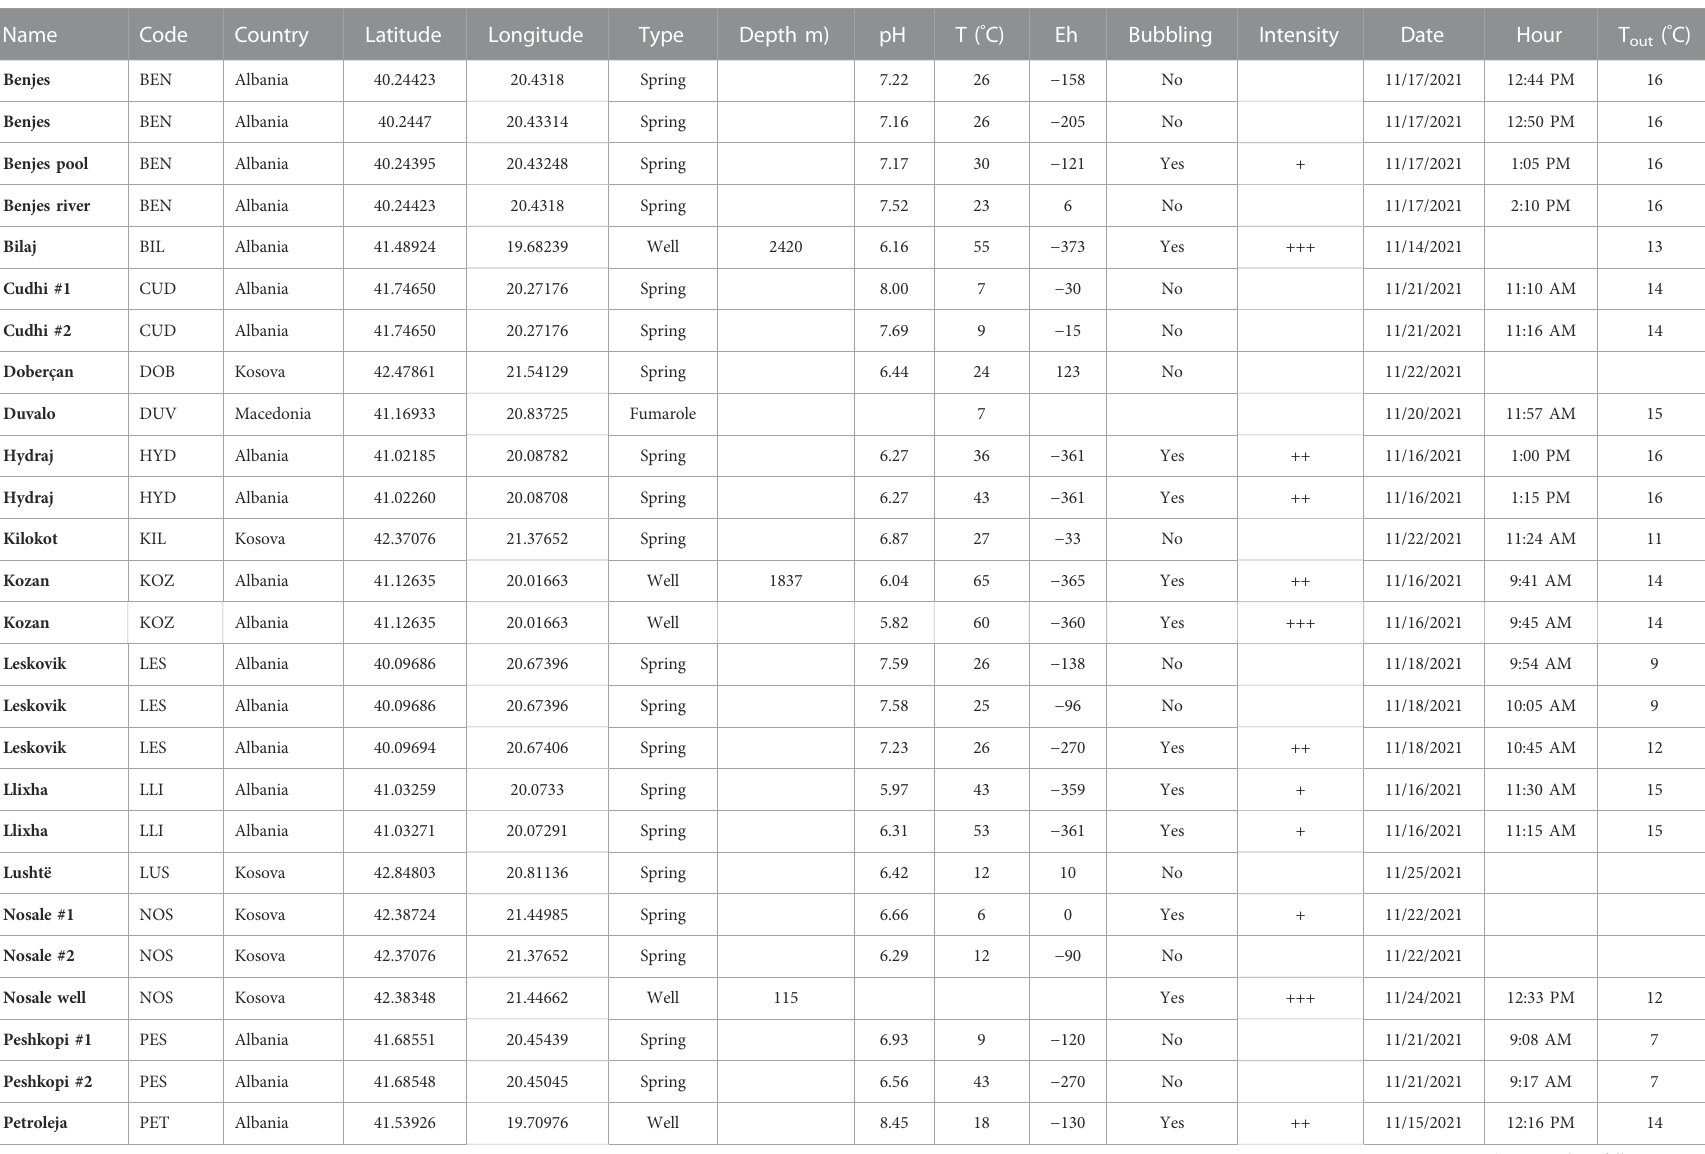
TABLE1Location ofthegasseepswiththecoordinates inWGS84datum,andparameters ofthewaterandtheweatherconditions associated withsampling.Theintensityofbubbling isqualitatively fromlow(+)tohigh(+++). T out is for the temperature of the air during sampling. The hour was reported because some daily variations can sometimes appear (Prinzhofer et al., 2019; Cathles and Prinzhofer,